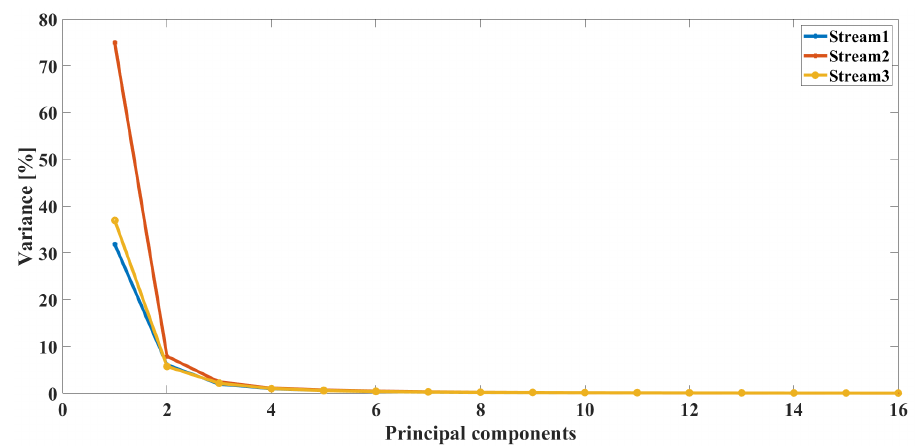
Figure 14. Variance in principal components post segmentation.